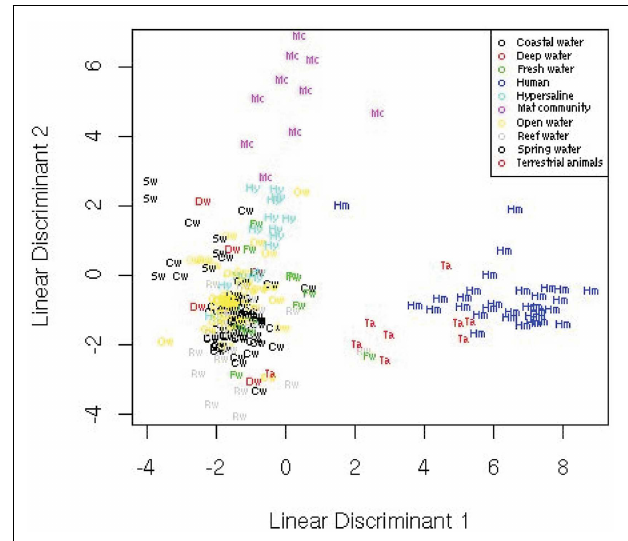
FIGURE 7 | Linear discriminant analysis showing the position of the metagenomes in two-dimensional space from the 10 environments.